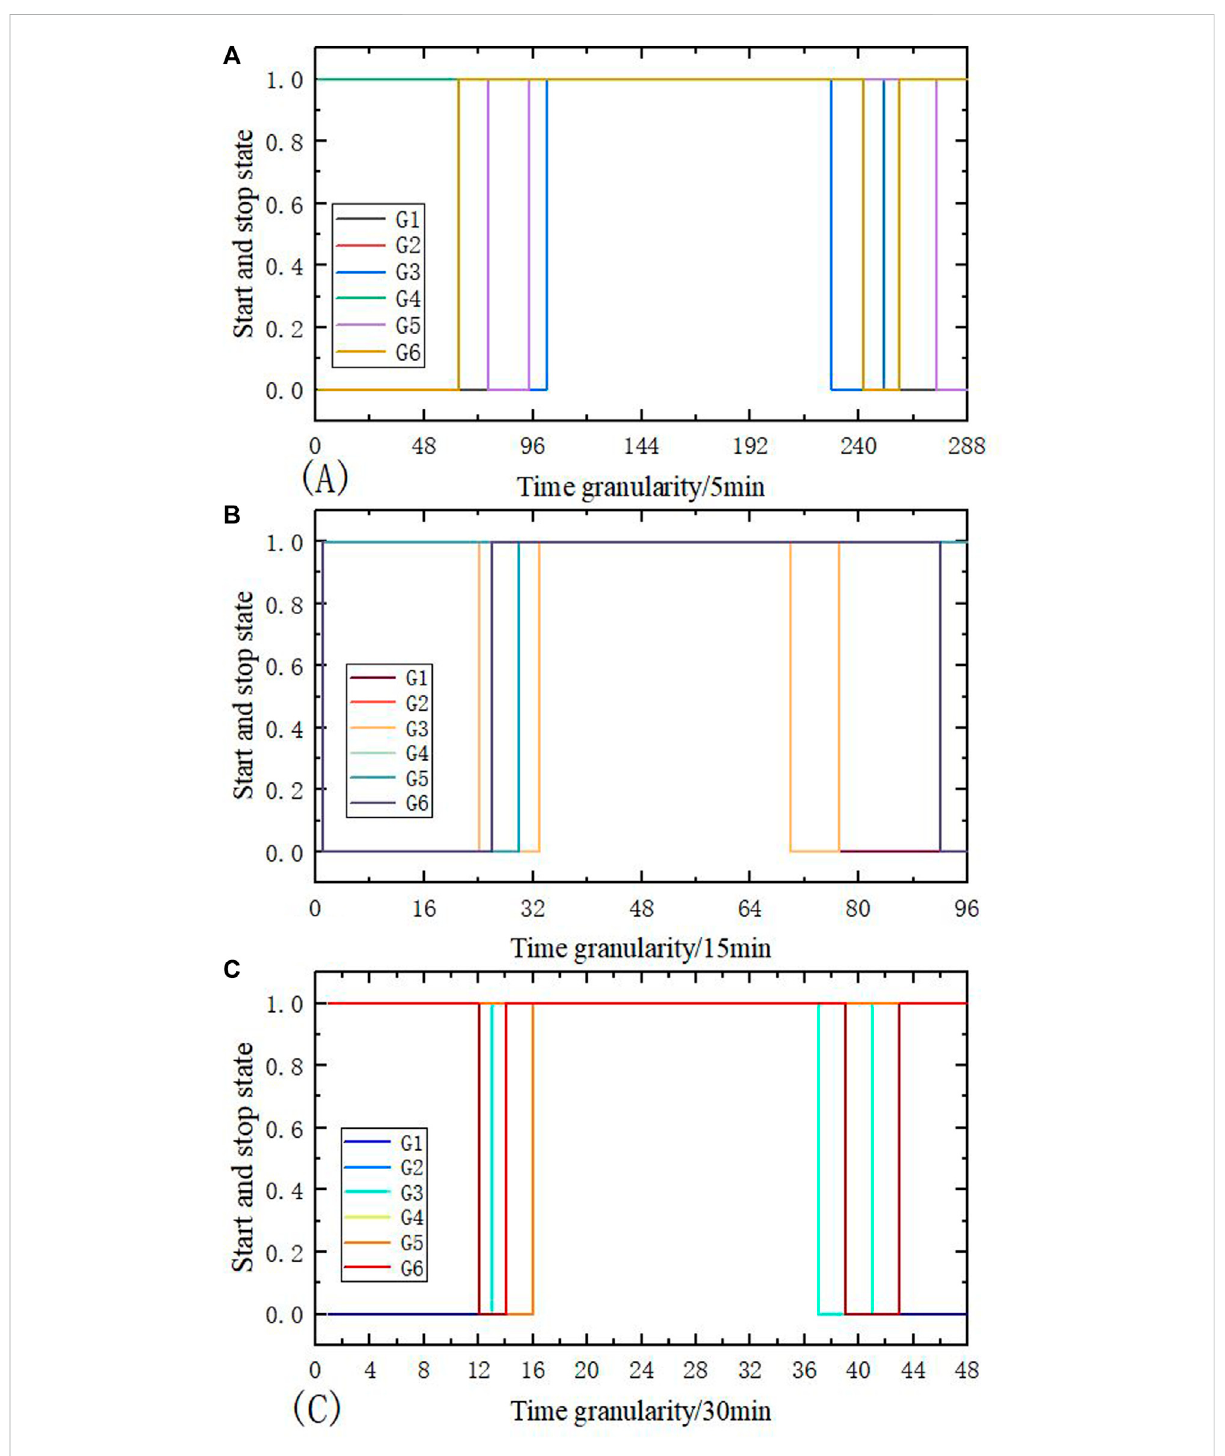
FIGURE 14 Startup and shutdown statuses of the thermal power unit under different models. (A) The start-stop state of the unit under the time granularity of 5 min; (B) The start-stop state of the unit under the time granularity of 15 min; (C) The start-stop state of the unit under the time granularity of 30